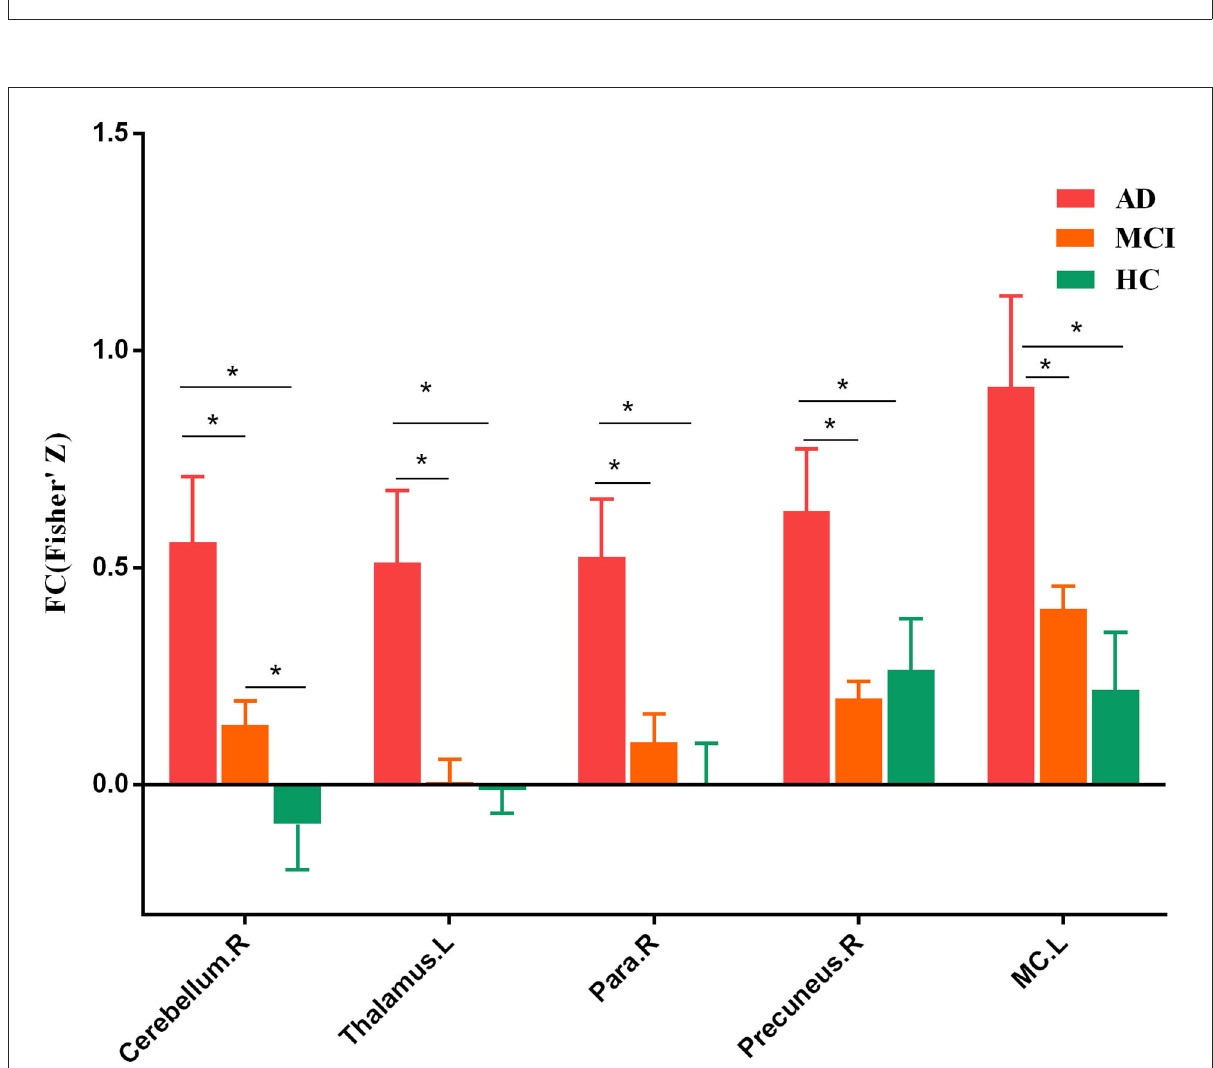
FIGURE3 Post-hoc results of seed-based functional connectivity. Para, parahippocampus. MC, middle cingulum. The “*” means that the difference is significant ( p <